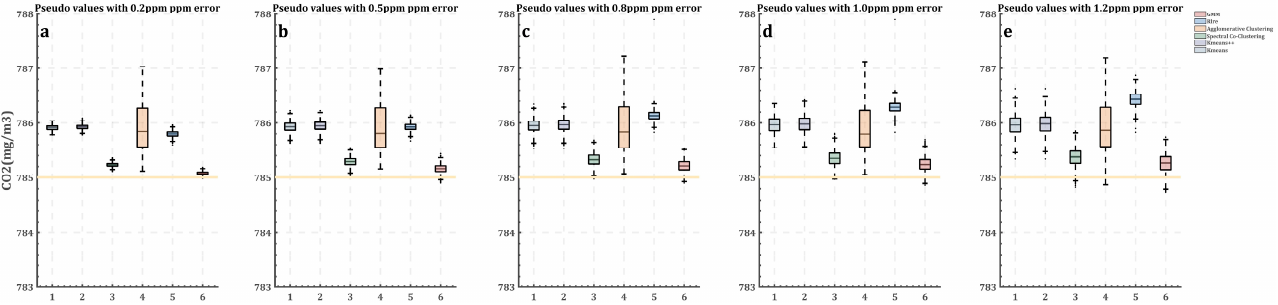
Figure 9. Background concentration estimates in pseudo measurements with a single peak.